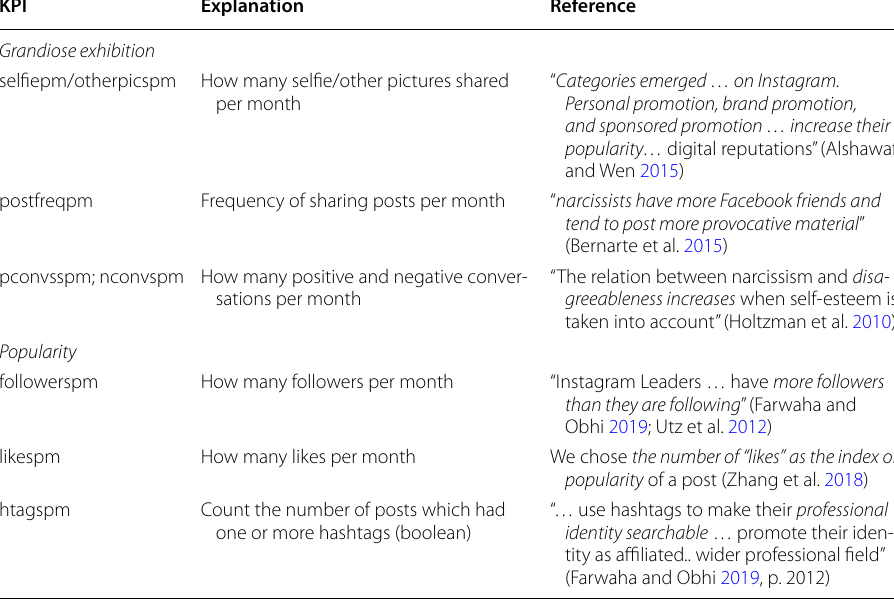
Table 3 KPIs to measures for popularity and narcissism along with their relevant literature KPI Explanation